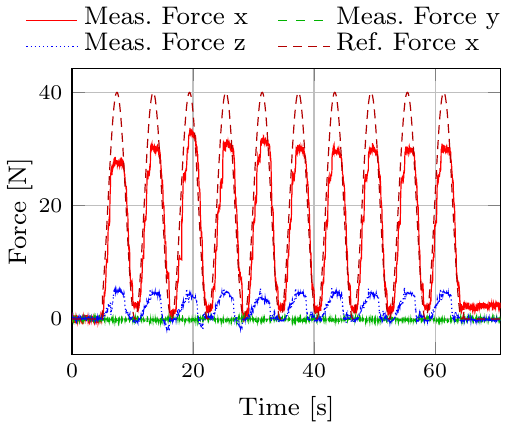
Fig. 12 End-effector forces generated using the open-loop model computation on the COMPI